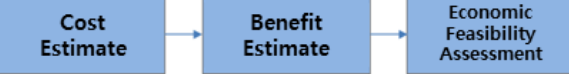
Figure 4. Economic feasibility analysis procedure.